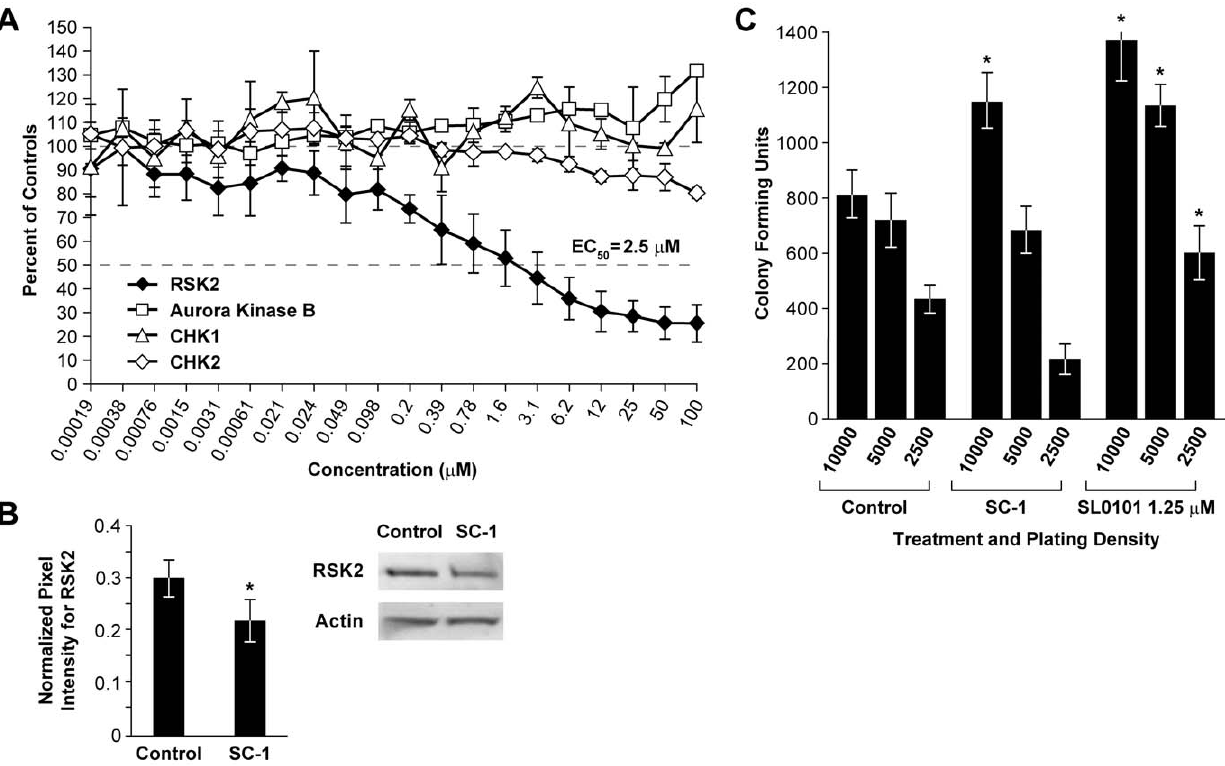
Figure 4. SC-1 Inhibited RSK2 Kinase Activity invitro and an RSK2 Inhibitor Increased Colony Formation. COLO 205 tumor cell line was treated with SL0101 (1.25 m M) and SC-1 (0.1 m M) for 24 hrs prior to soft agar cloning, lysate preparation, and immunoblotting. A. SC-1 inhibited RSK2 N-terminal domain in vitro kinase activity with an EC 50 of 2.5 6 1.8 m M (mean 6 SD, n=5) but not in other like assays for Aurora kinase B, CHK1, or CHK2 kinases. B. Decreased RSK2 protein levels (33%) were found at 5 days following SC-1 treatment in the COLO 205 tumor line (n=2). C. Treatment (24 hrs) of COLO 205 tumor line with SL0101, a kaempferol glycoside RSK2 inhibitor, increased colony formation ( $ 60 m m) in soft agar (n=2, representative experiment shown).